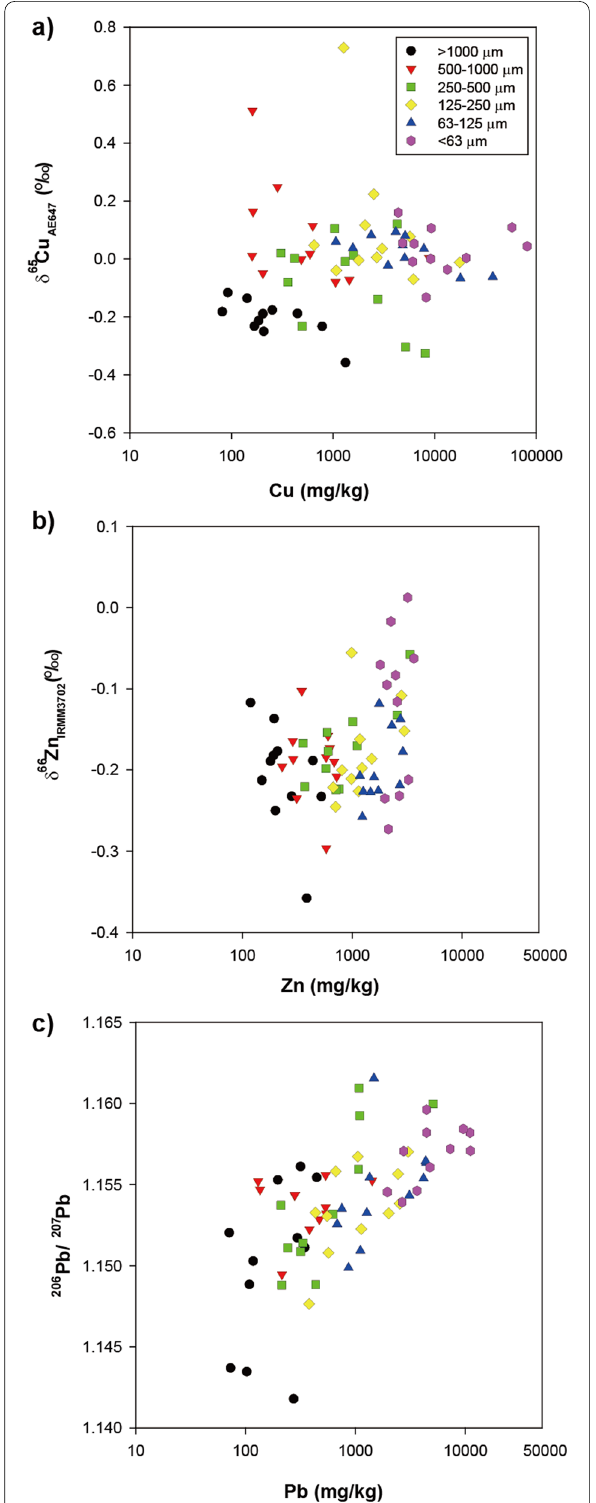
Fig. 3 Comparison of isotopic composition and concentration (mg/ kg) for Cu ( a ), Zn ( b ), and Pb ( c ) in the different particle sizes of RDS samples of this